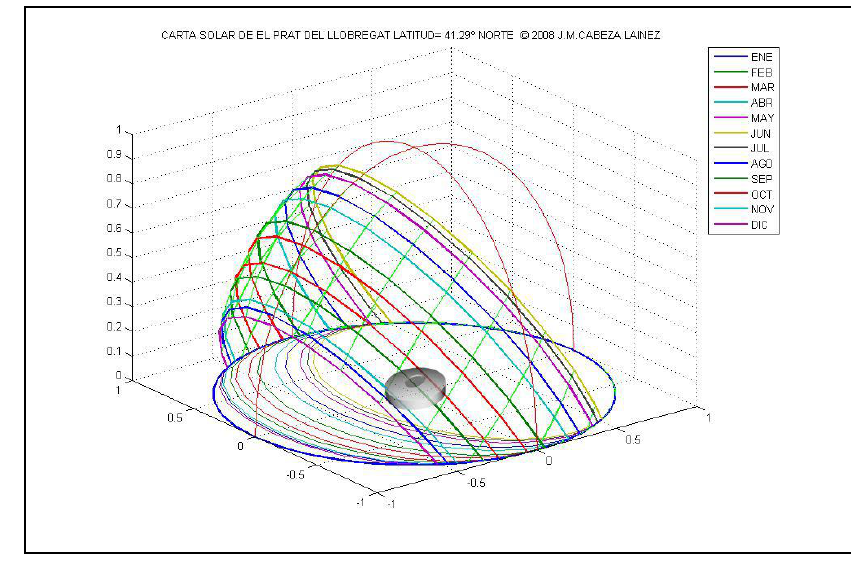
Figure 22. Solar chart for the railway hub.